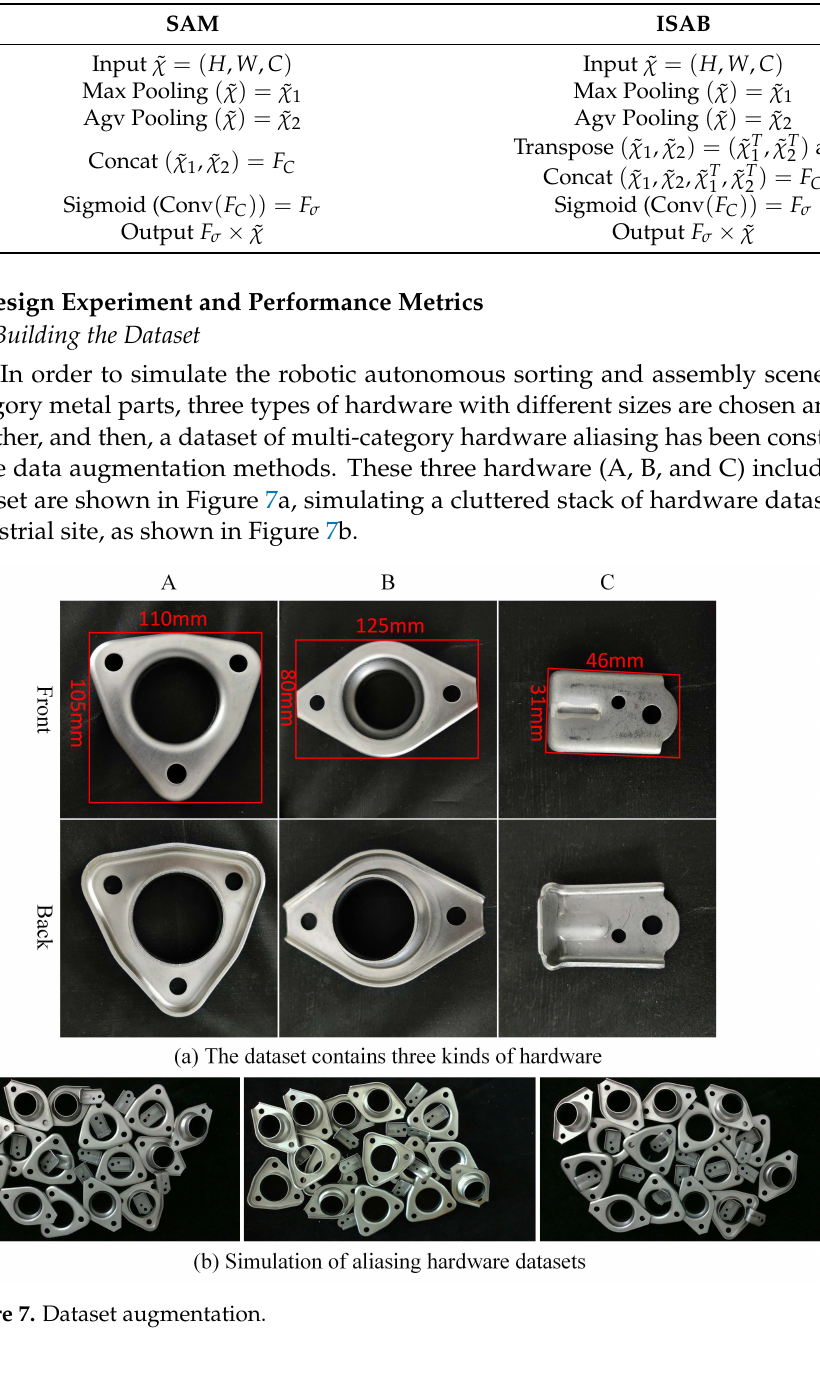
Figure 6. Structure of Improved Spatial Attention Block. Table 1. Comparison of SAM and ISAB.